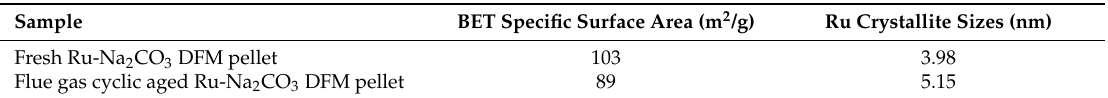
Table 1. Brunauer-Emmett-Teller (BET) specific surface area of the fresh and flue gas cyclic aged Ru-Na 2 CO 3 DFM pellets. Ru crystallite sized for fresh and cyclic aged samples based on H 2 chemisorption assuming H/Ru = 1/1.